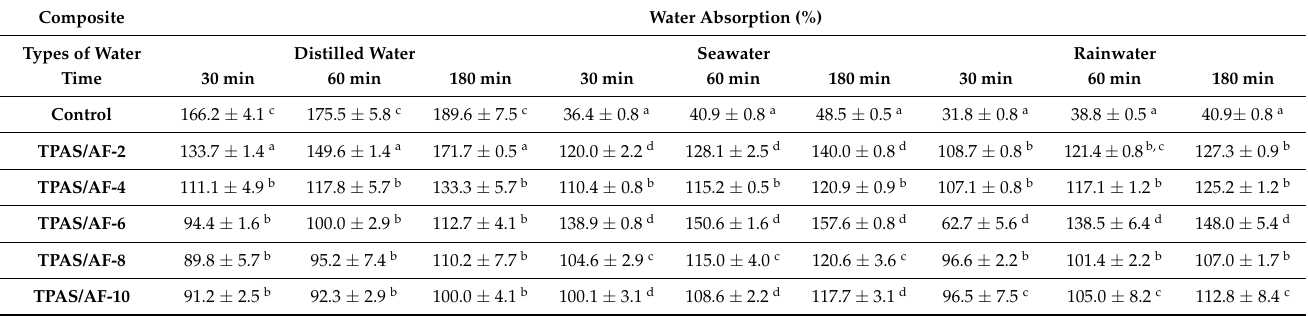
Table 3. Effect of different environmental conditions on water absorption of TPAS/AF compos- ite